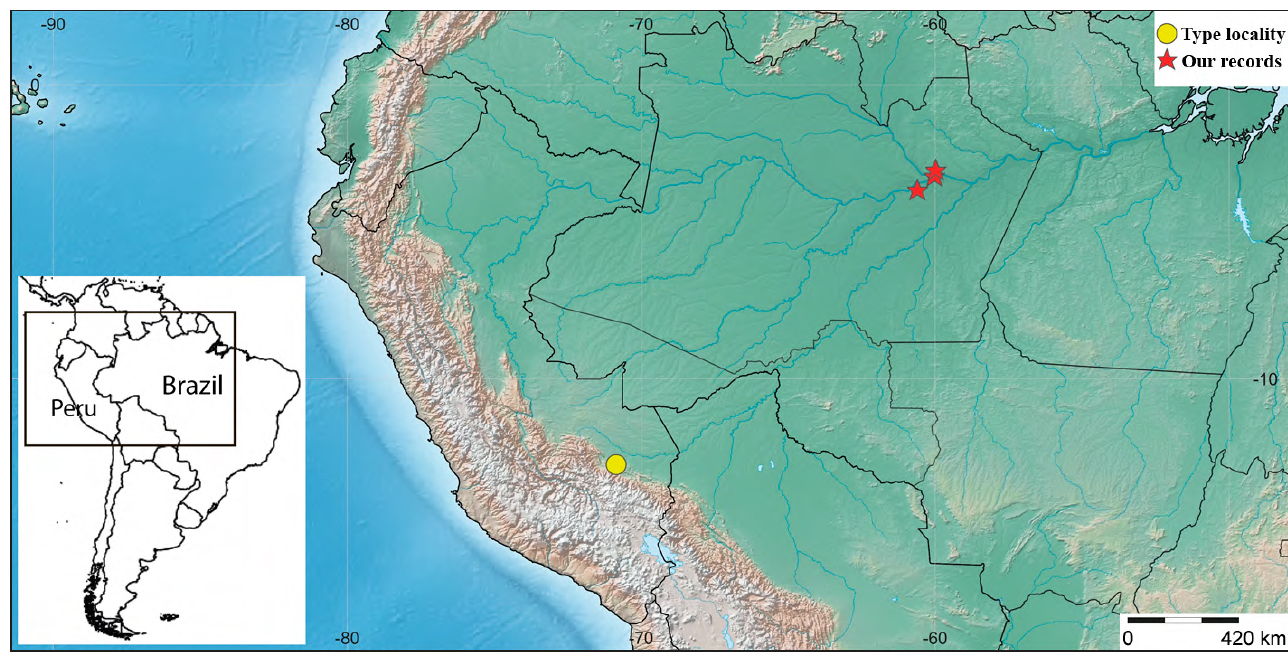
Figure 6. Distribution map of Clistopyga melanoptera Castillo, Sääksjärvi & Bordera, 2016 in South